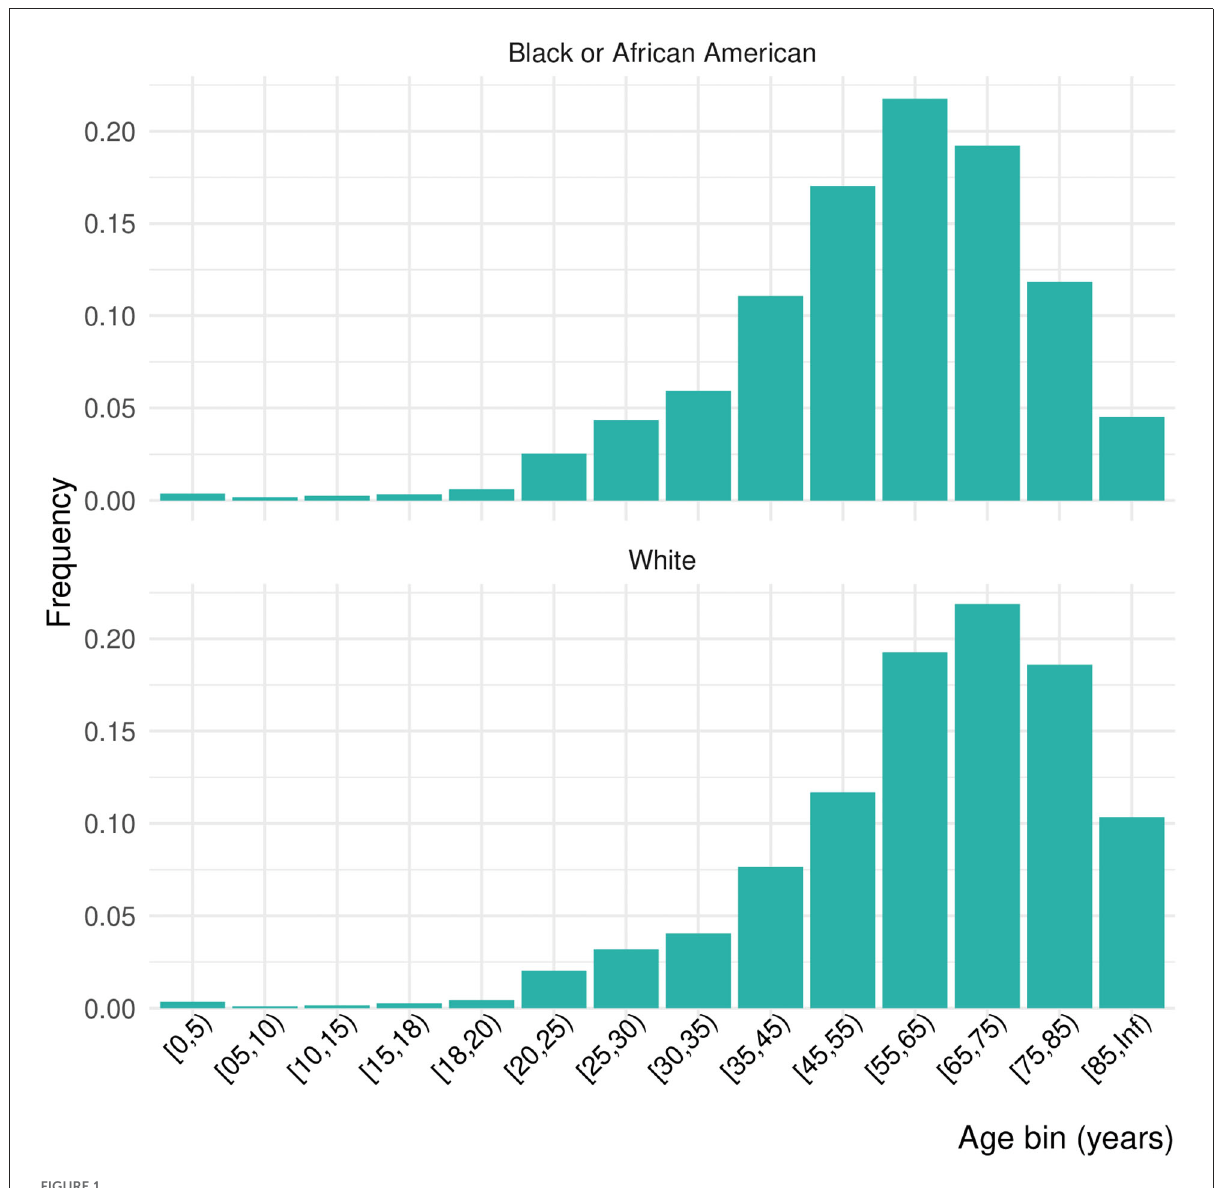
FIGURE1 Distribution of ages by age bin and race.